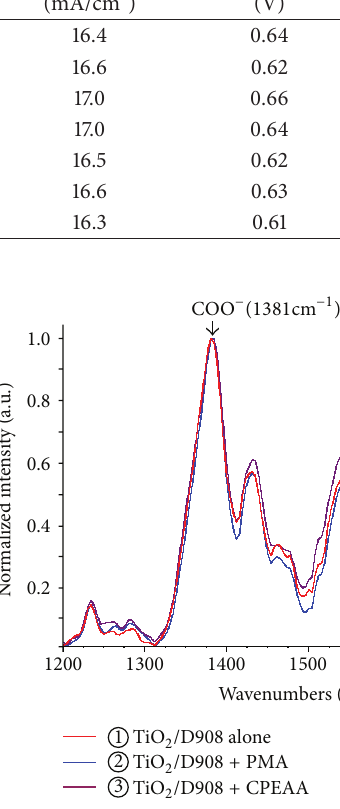
Figure 4: ATR-FTIR spectra of TiO 2 films sensitized with D908 alone, D908 with PMA, and D908 with